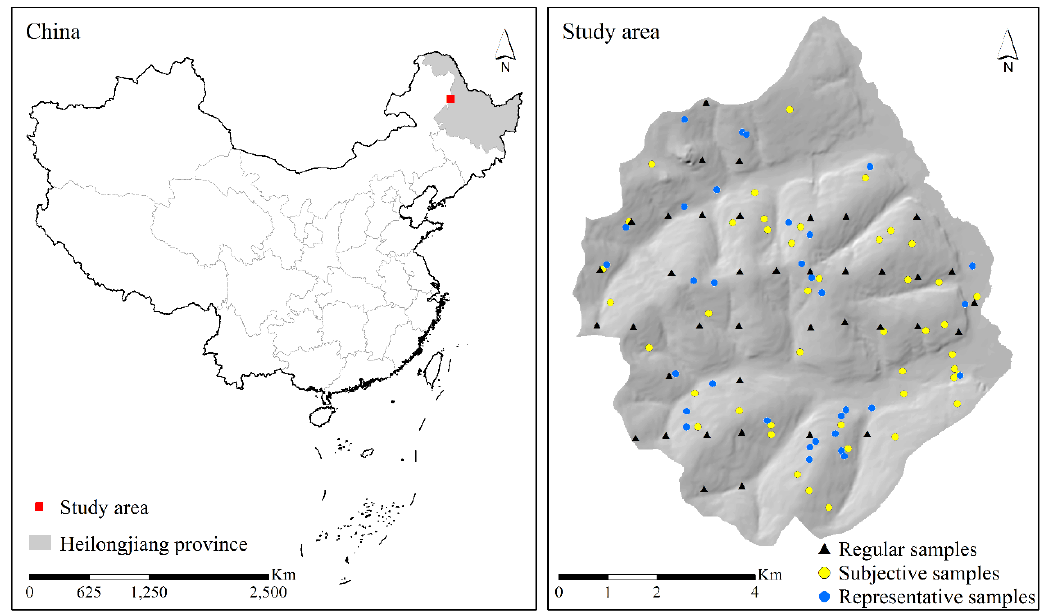
Figure 1. The study area and soil samples. Table 1. Description of environmental covariates.